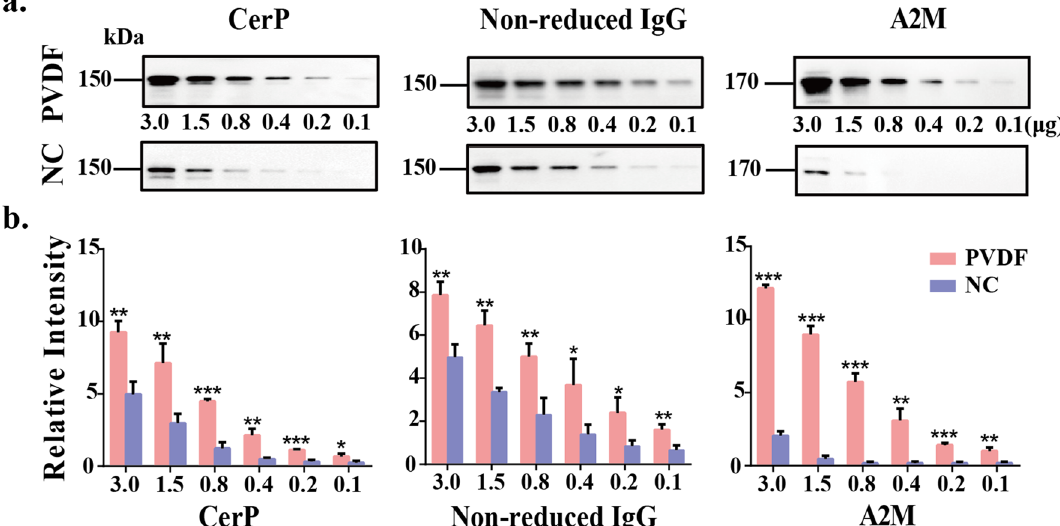
Figure 3. Comparison of the binding ability of PVDF membrane and NC membrane to high molecular weight proteins. ( a ) The mixed sera of healthy samples were diluted by gradient (3.0, 1.5, 0.8, 0.4, 0.2 and 0.1 μg). Then the sera were separated by 8% SDS-PAGE. The proteins were transferred onto PVDF membranes (up) and NC membrane (down), respectively. The membranes were incubated with anti-CerP, anti-IgG and anti-A2M. ( b ) Staining intensities were statistically analyzed (n = 3 individual experiments). Pink bar, PVDF membrane; Blue bar, NC membrane. Band intensities were analyzed and compared using Image Lab software (Bio-Rad Laboratories) and GraphPad Prism version 6. *Significantly different p < 0.05, ** p < 0.01, *** p < 0.001. All values are means ± S.E. (error